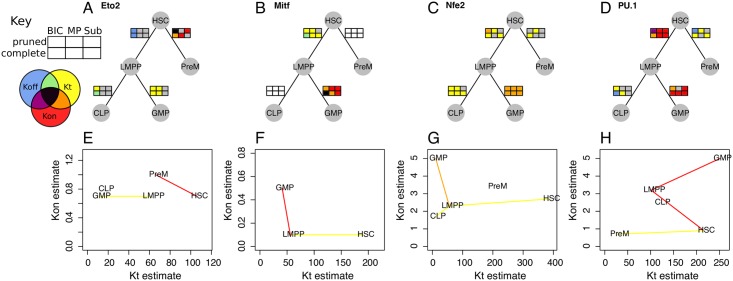
Transcription factor-specific kinetic parameter changes.For each specific gene, it is possible to use EPiK to predict which kinetic parameters vary throughout differentiation. (A-D) For each transition between populations of cells, the kinetic parameter changes are predicted for each TF using all six methods shown in the key, which we represent by six colored rectangles– the color corresponds to the parameters predicted to have changed, as designated in the key. If there are not enough cells with a certain gene expressed in order to calculate parameter changes, then the rectangles are depicted as white. The results are shown for a selection of TFs: Eto2 (A), Mitf (B), Nfe2 (C), and PU.1 (D). (E-H) To demonstrate that EPiK provides reasonable results, we depict the maximum likelihood estimates for Kt and Kon for each population of cells (pruned dataset). If there is a predominant change in Kon (red), Kt (yellow), or both variables (orange), then these populations are connected by lines of the corresponding color.